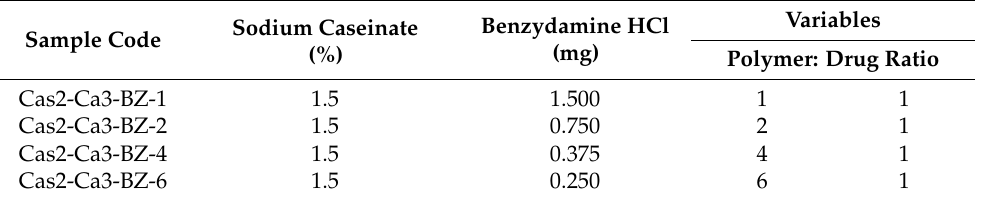
Table 2. Composition of BZ-loaded casein nanoparticles of various